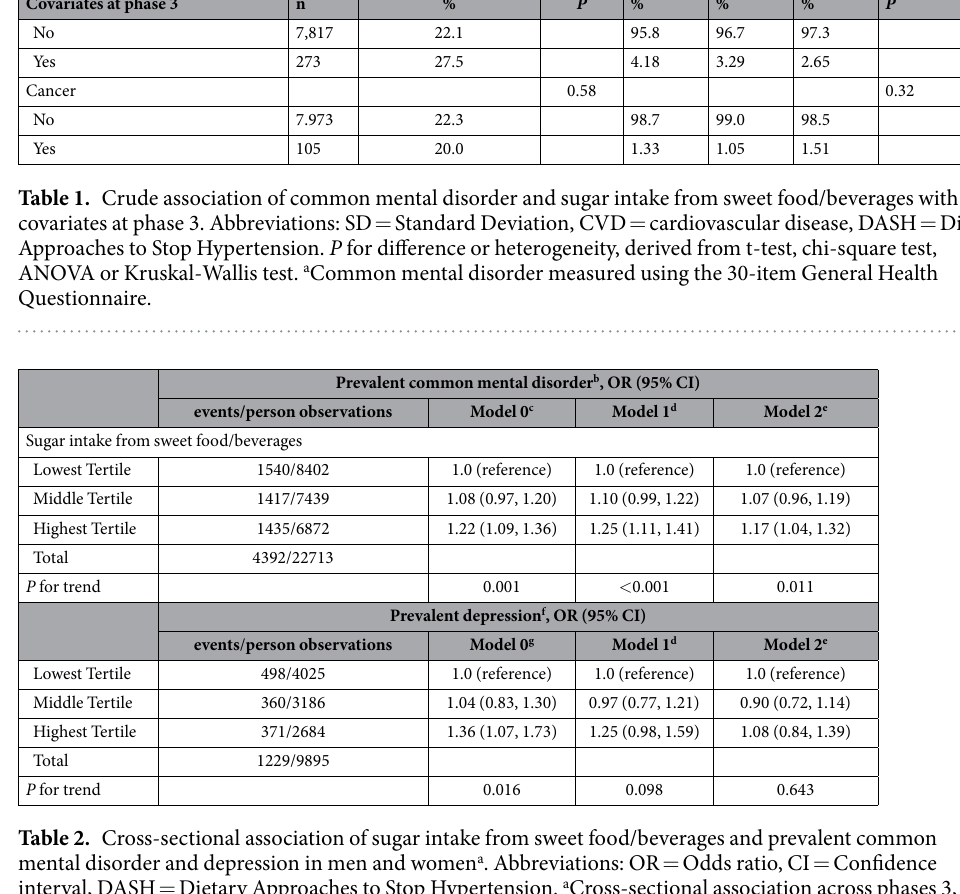
5 Scientific REpoRtS | 7: 6287 | DOI:10.1038/s41598-017-05649-7